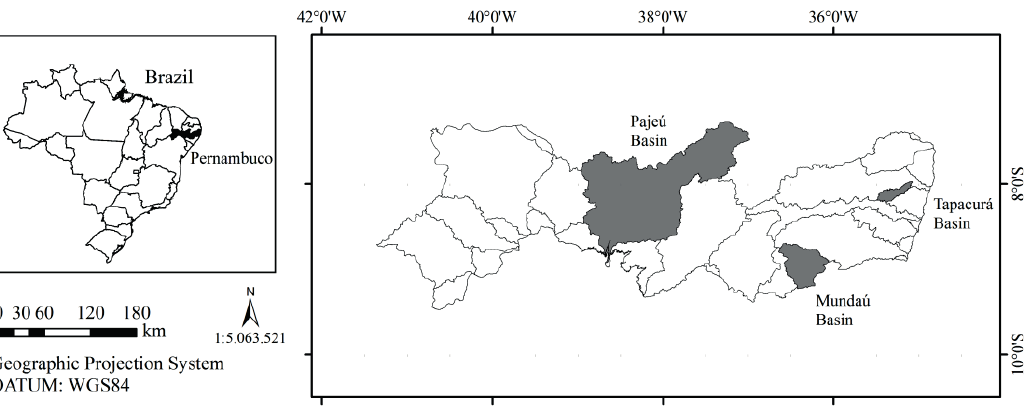
Fig. 1 Location of Pajeú, Mundaú and Tapacurá basins in Pernambuco,